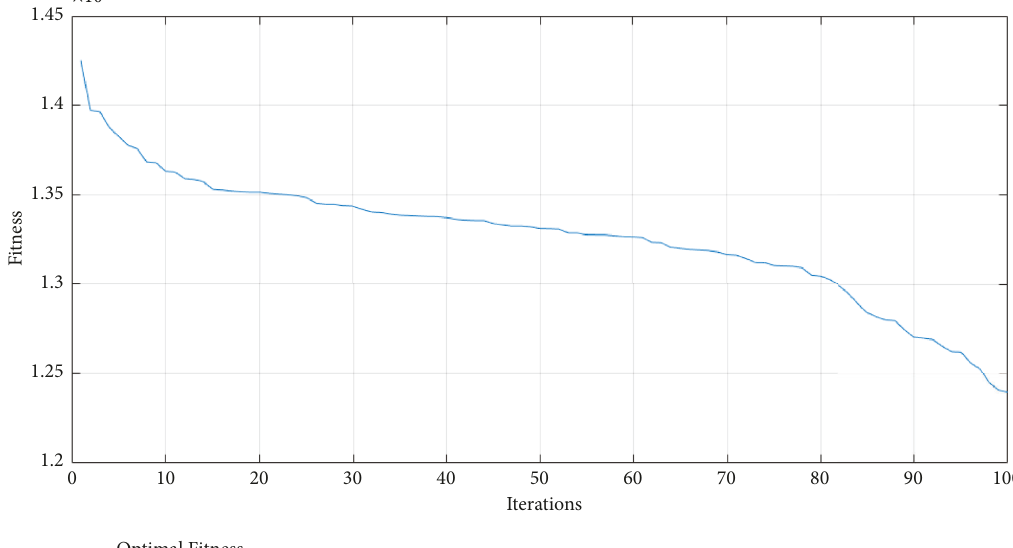
Figure 8: Convergence process of the fitness in the peak period.